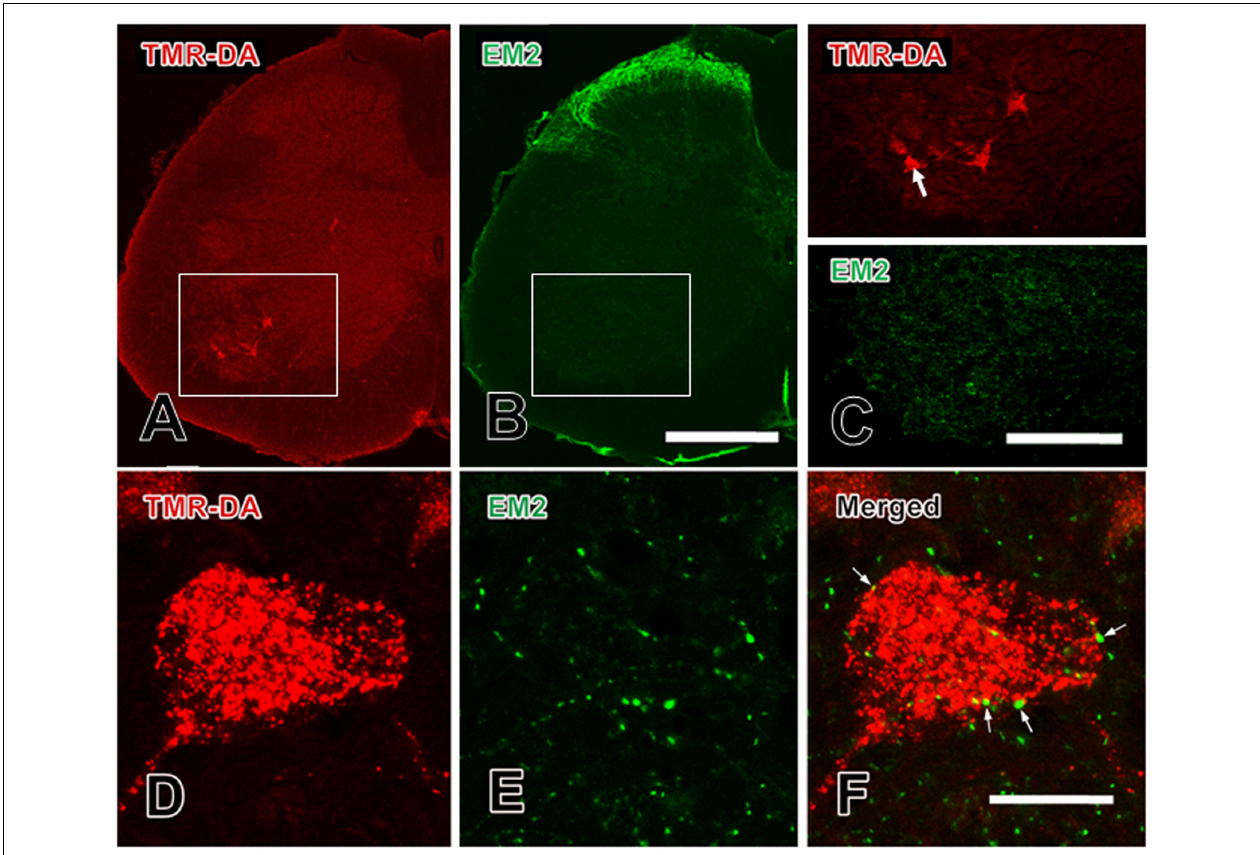
FIGURE 1 | Close contacts between EM-2-IR terminals and TMR-DA retrogradely labeled motoneurons in the spinal ventral horn. (A) TMR-DA labeled motoneurons in lamina IX; (B) EM-2-IR fibers and terminals in spinal dorsal and ventral horns; (C) the areas indicated with white rectangles in (A) and (B) was enlarged in (C) to show the morphological features of the TMR-DA labeled motoneurons and EM-2-IR fibers and terminals in lamina IX; (D–F) the close contacts (indicated with small white arrows) between EM-2-IR fibers and terminals and a TMR-DA labeled motoneuron indicated with a large white arrow in (C) . Scale bars = 280 µ m in (A) and (B) , 140 µ m in (C) , and 20 µ m in (D–F)